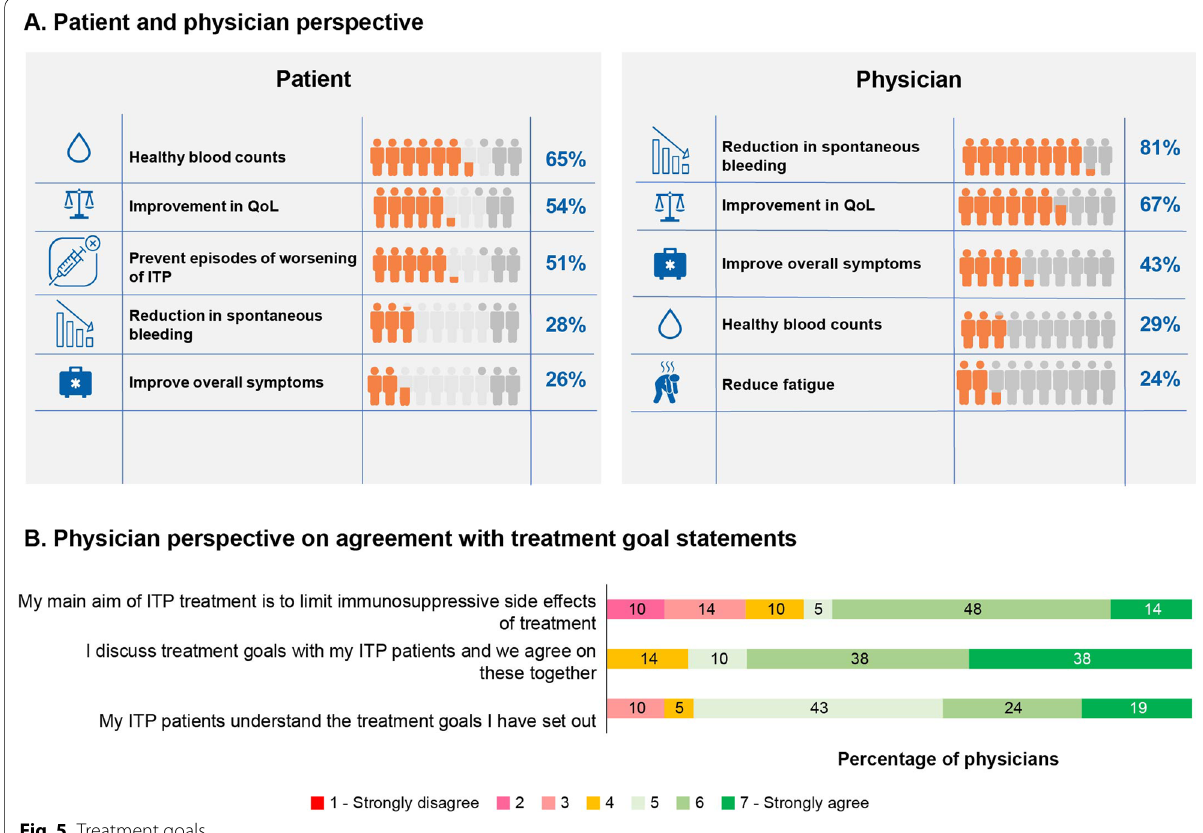
Fig. 5 Treatment